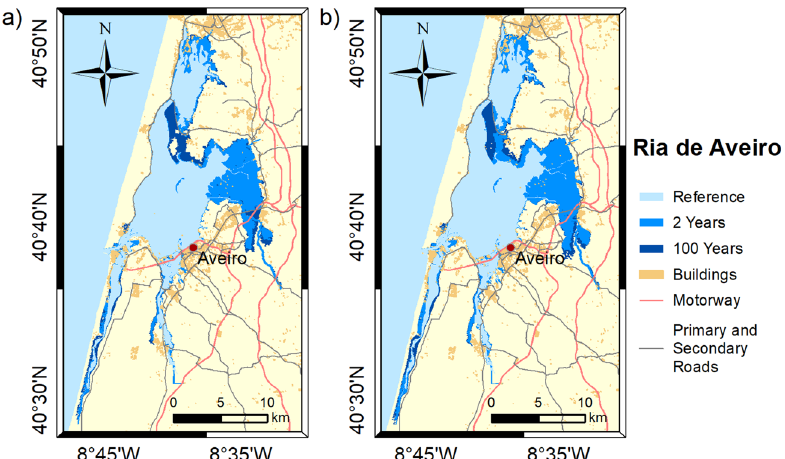
Figure 3. Inundation extents induced by extreme sea levels with return periods of 2 and 100 years on the Ria de Aveiro in: ( a ) 2046–2065; and ( b ) 2081–2100. These maps were created with Esri ArcGIS 10.8 software (https:// www. esri. com/ en- us/ home).